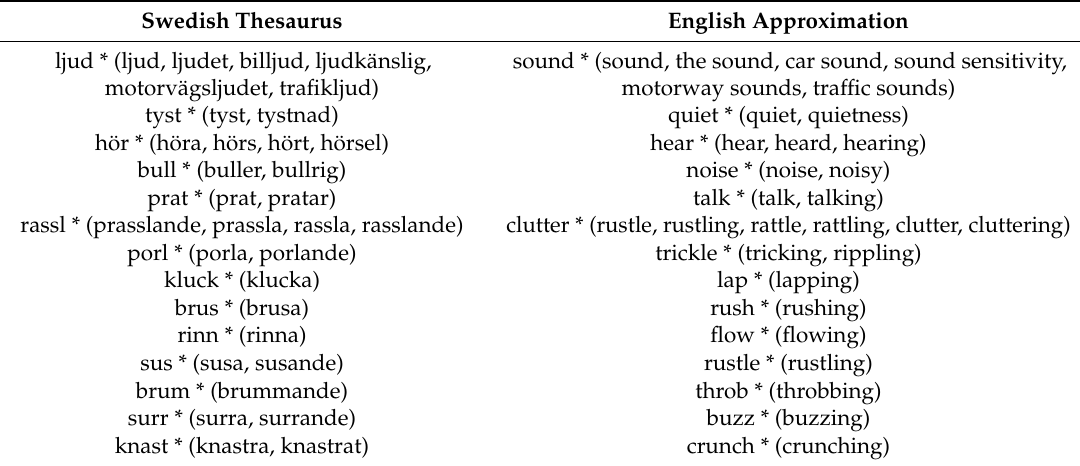
Table A1. Thesaurus of